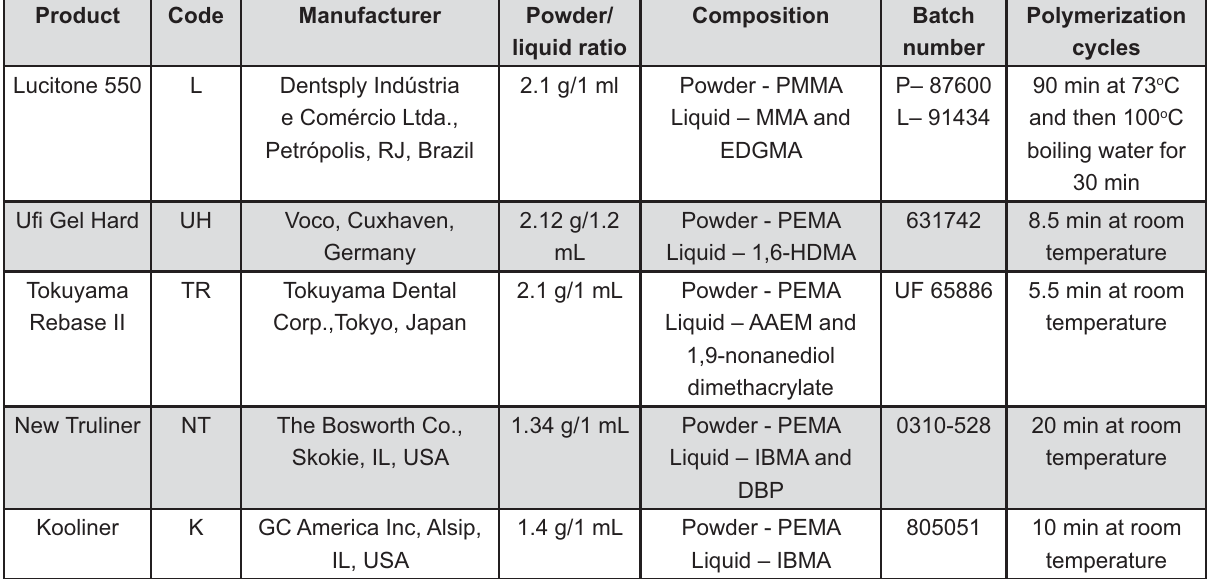
Figure 1- Materials used in this